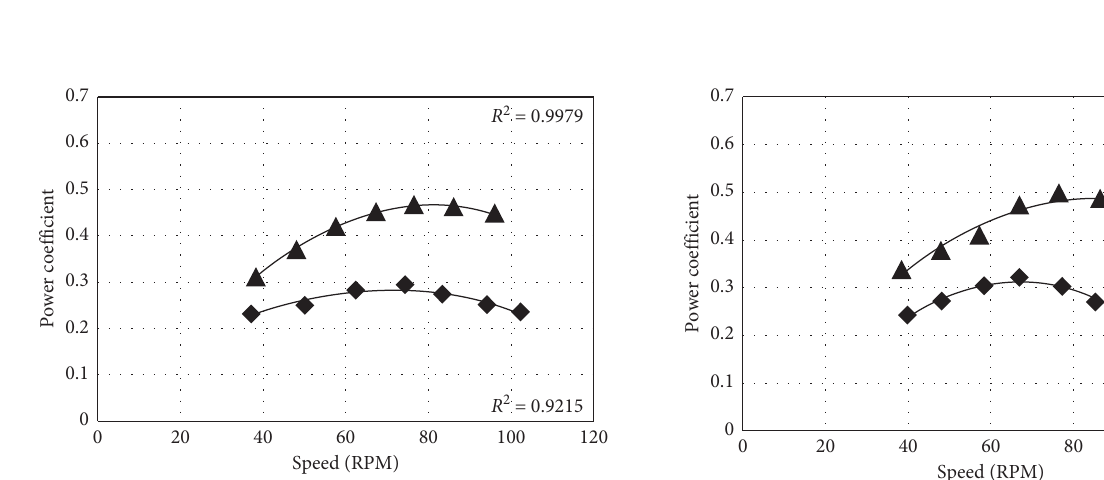
Figure 21: Runner 4 data points.